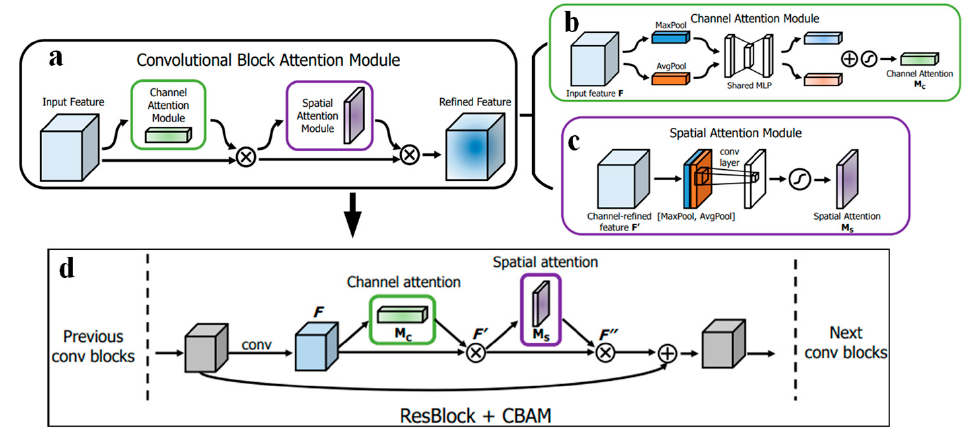
Figure 4. Outline of CBAM: ( a ) overall structure of CBAM, ( b ) channel attention unit, ( c ) spatial attention unit, ( d ) integrated application mode of CBAM.